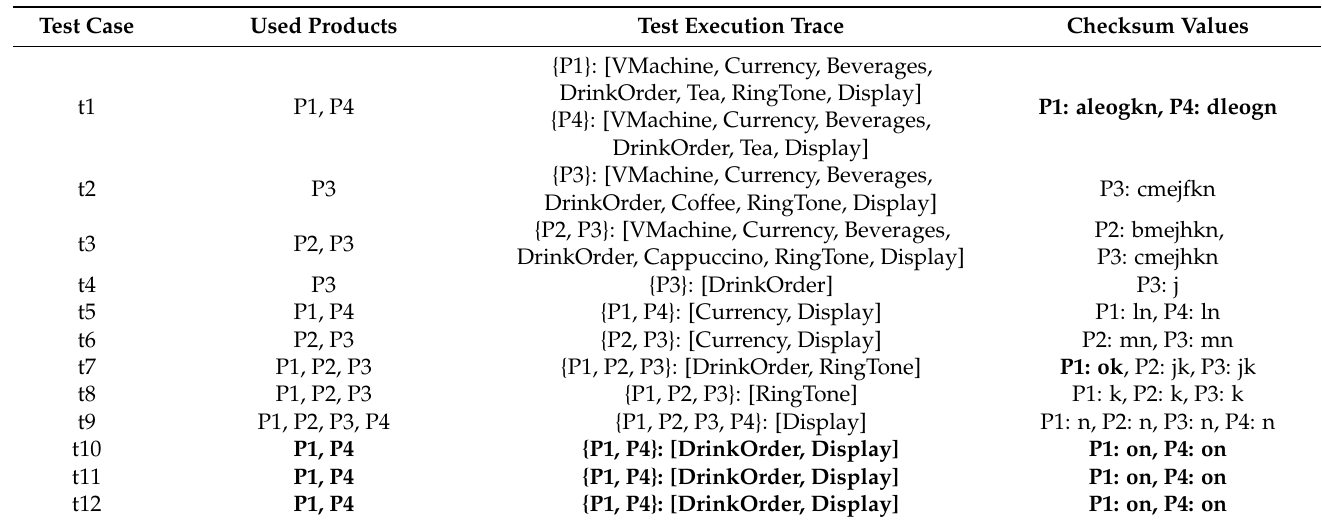
Table 9. Execution traces of test cases and their checksum values for SPL V1 . Checksum values changed in SPL V0 are presented as bold